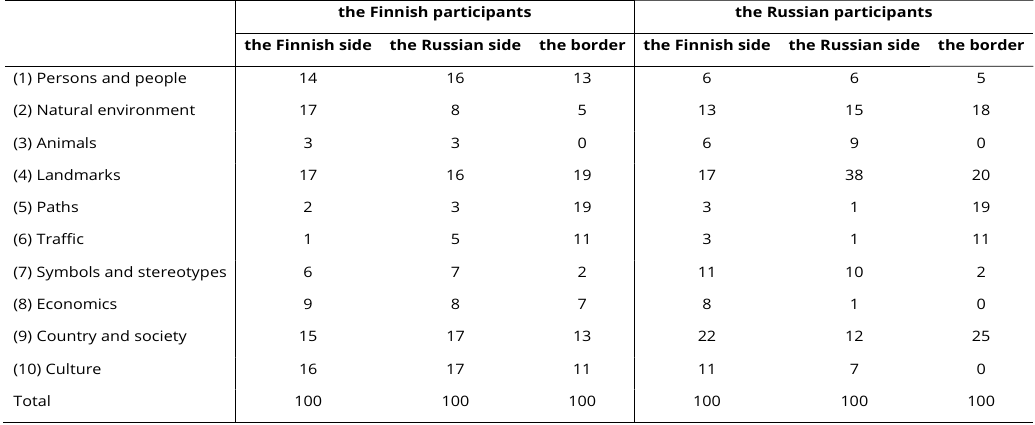
Table 2 . Map elements by category (percentage of total in each location,